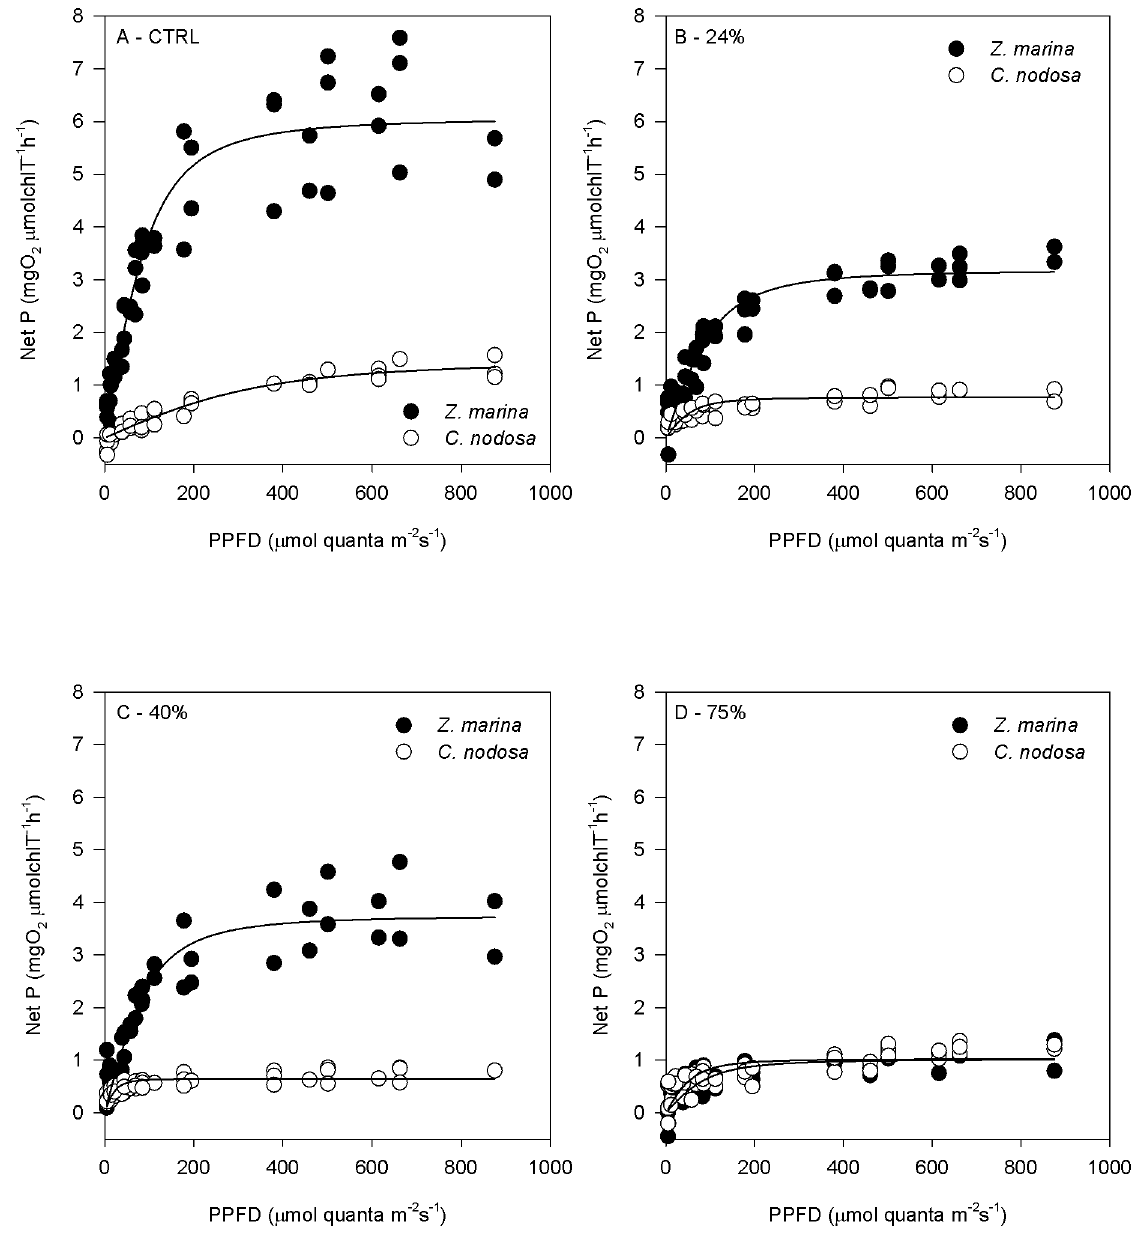
Figure 1. Light response curves of Zosteramarina and Cymodoceanodosa . Plants submitted to shading treatments of 24, 40 and 75% of naturally available photosynthetically active radiation (CTRL). The model equation of Smith and Talling [15] [16] was adjusted to the observed points.